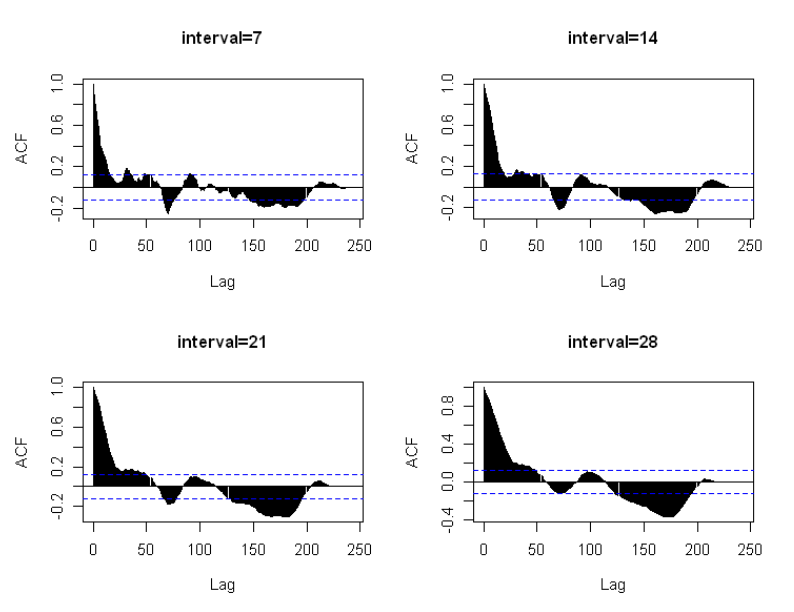
Figure 8. Autocorrelation (ACF) plot of interval length 7, 14, 21 and 28 in Group